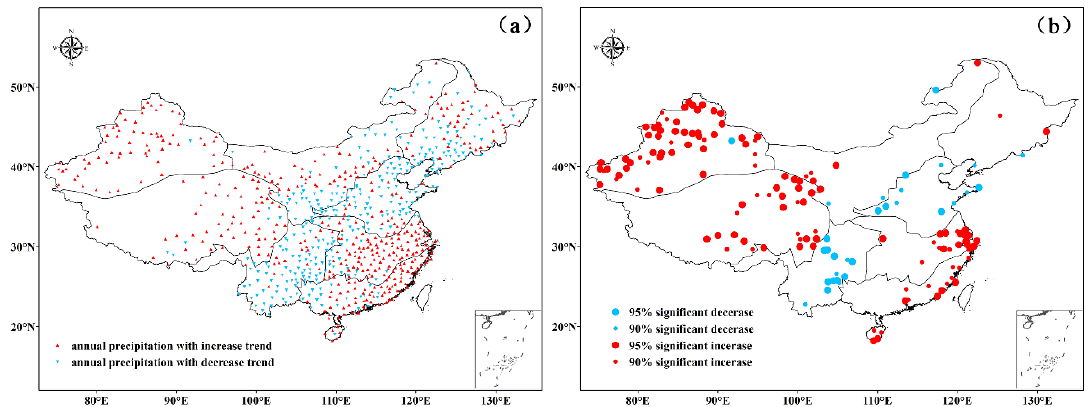
Figure 3. The spatial distribution of rainfall stations displaying negative or positive annual rainfall trends across China. ( a ) The overall station trends (The blue downward triangles denote decreasing trends; the red upward triangles denote increasing trends) and ( b ) the stations exhibiting statistically significant trends (The blue circles denote decreasing trends, the red circles denote increasing trends, the bigger circles show trends exhibiting a 95% significance level detected by the Mann–Kendall test; and the smaller circles show trends exhibiting a 90% significance level detected by the Mann–Kendall test).